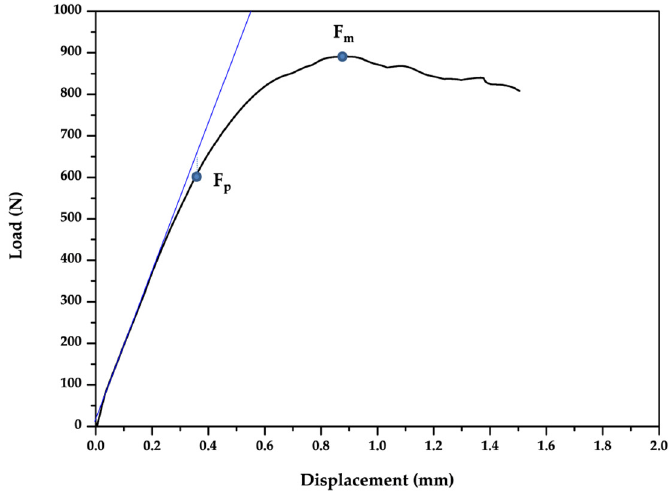
Figure 3. Representative load–displacement curve of a specimen. The force (F p ) at which the load– displacement curve first deviated by 10% from the regression line in the elastic interval was recorded as an indicator for plastic deformation. The maximum force (F m ) registered was regarded as the load–bearing capacity.